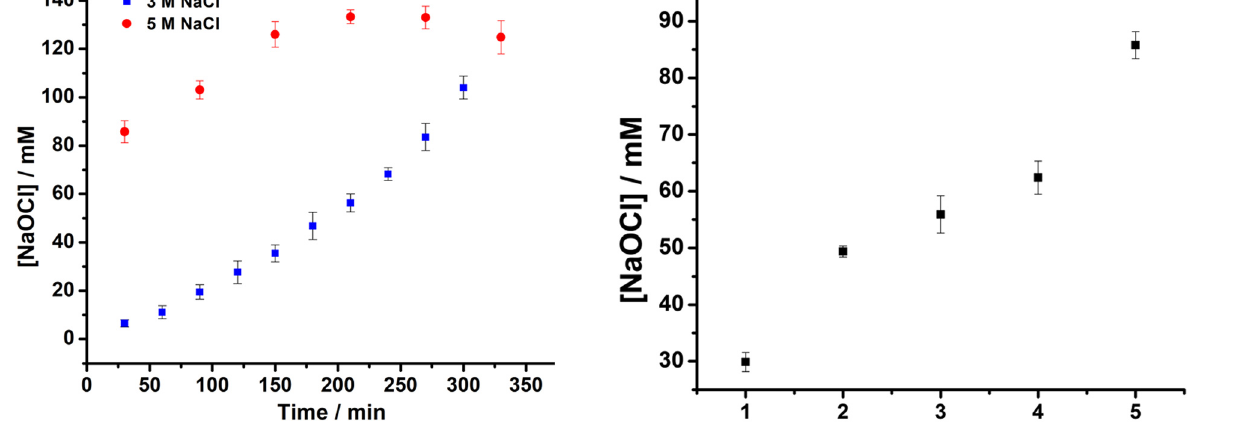
Figure 2: Concentration of NaOCl electrolyzed using 3 and 5 M NaCl at varied times.